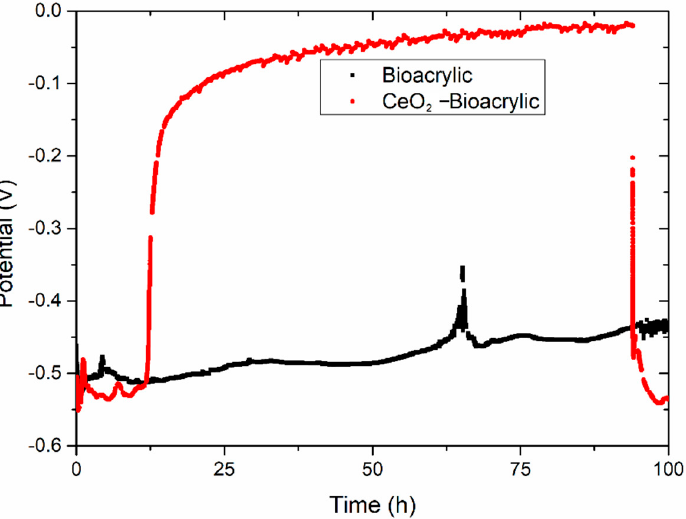
Figure 6. Open circuit potential of both Bioacrylic binders with an artificial defect after exposure to 3.5 wt% NaCl solution.